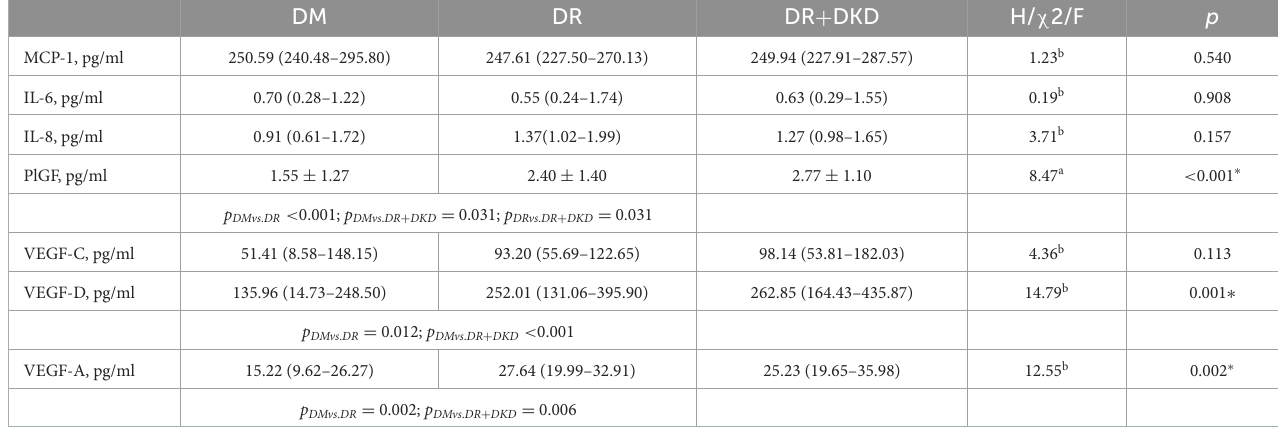
TABLE 2 Comparison of plasma inflammatory and angiogenic cytokines in subjects with DM, DR, and DR + DKD. DM DR DR + DKD H/ χ